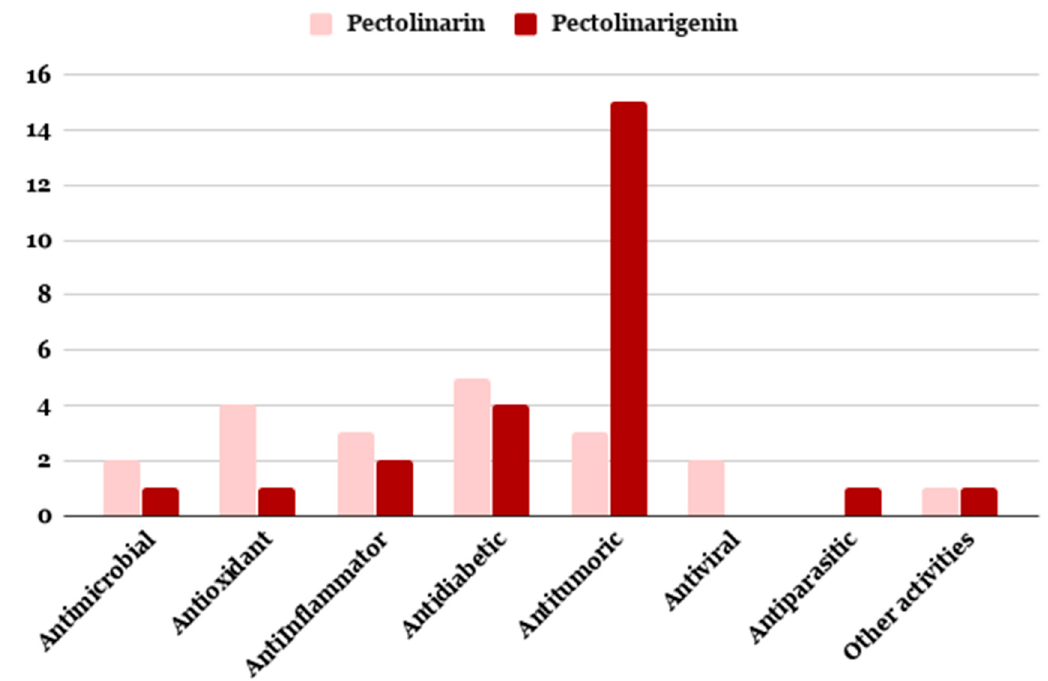
Figure 5. Distribution of the biological activities reported for pectolinarin and pectolinarigenin.